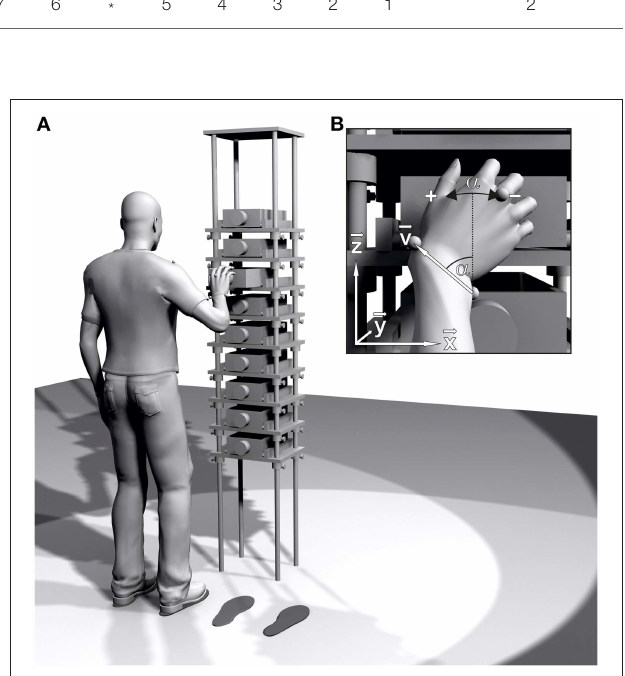
FIGURE 1 | (A) Schematic of the experimental setup. Drawer height, drawer spacing, and participant’s positions are scaled based on shoulder height and arm length. Black footprints mark the participant’s positions for left/right handed task execution. (B) Pro/supination angle α at the moment of drawer grasp. The projection of the wrist vector v onto the drawer face ( x - z -plane) is used to calculate α .